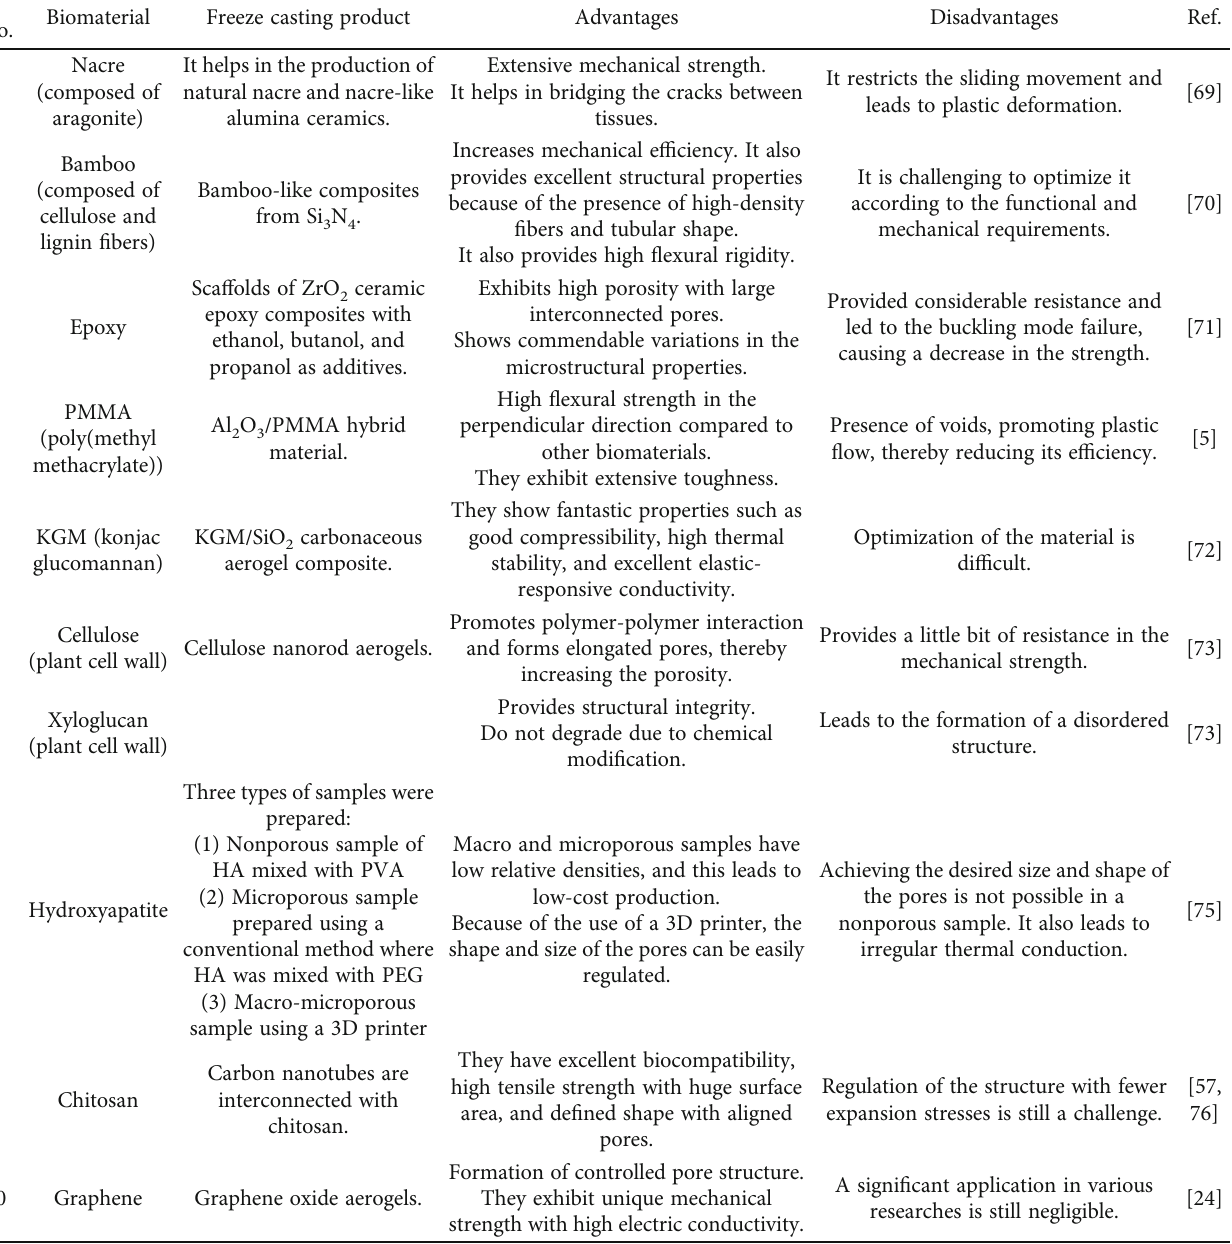
Table 3: Bioinspired material used in freeze